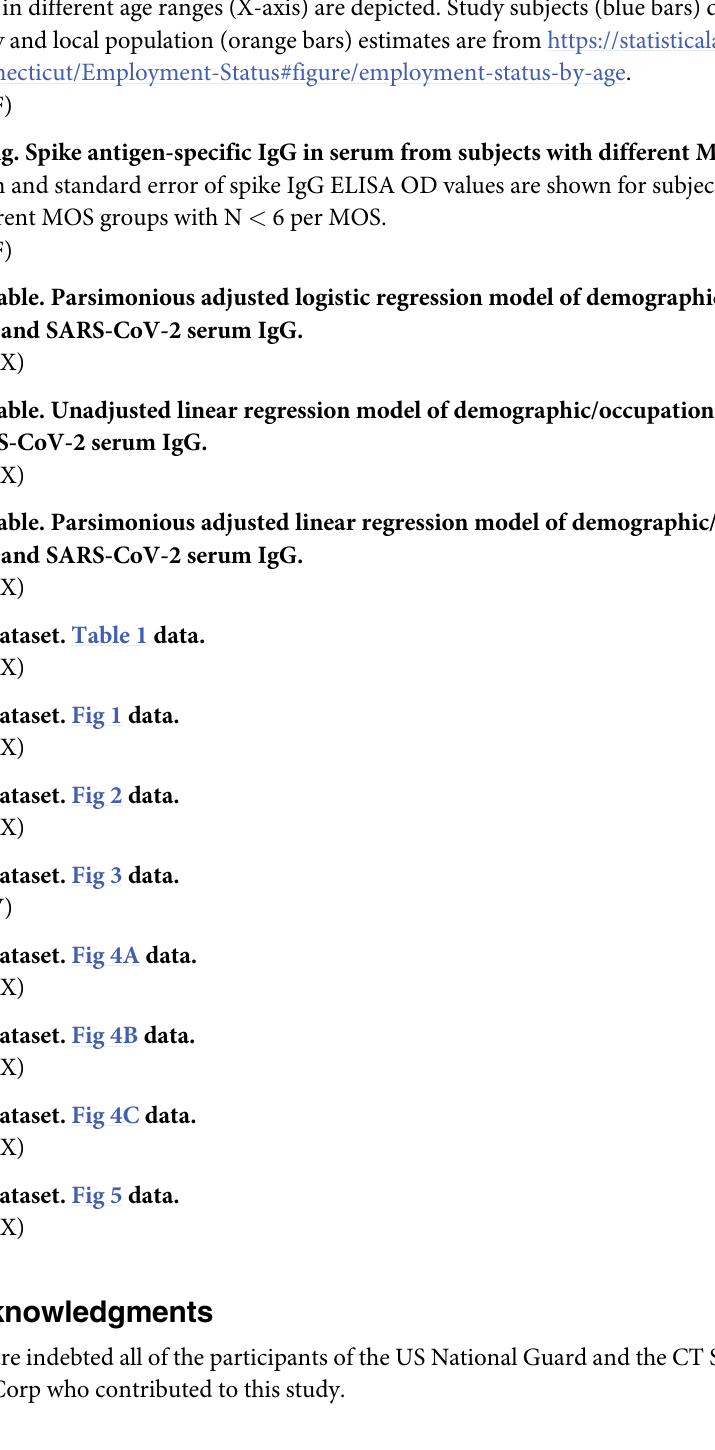
S6 Dataset. Fig 4B data. S7 Dataset. Fig 4C data. S8 Dataset. Fig 5